Question: Express in one sentence what the figure is showing.
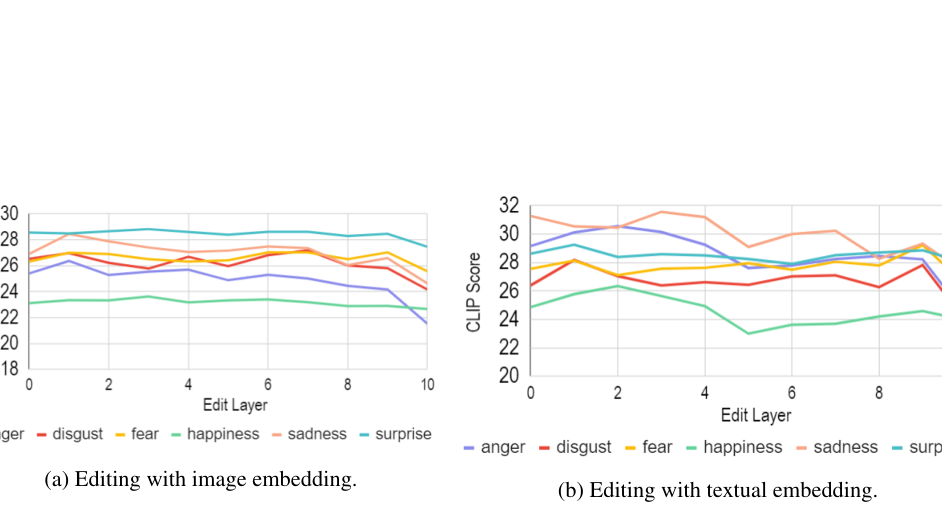
Answer: CLIP score of different emotions on the generated images after editing each later.